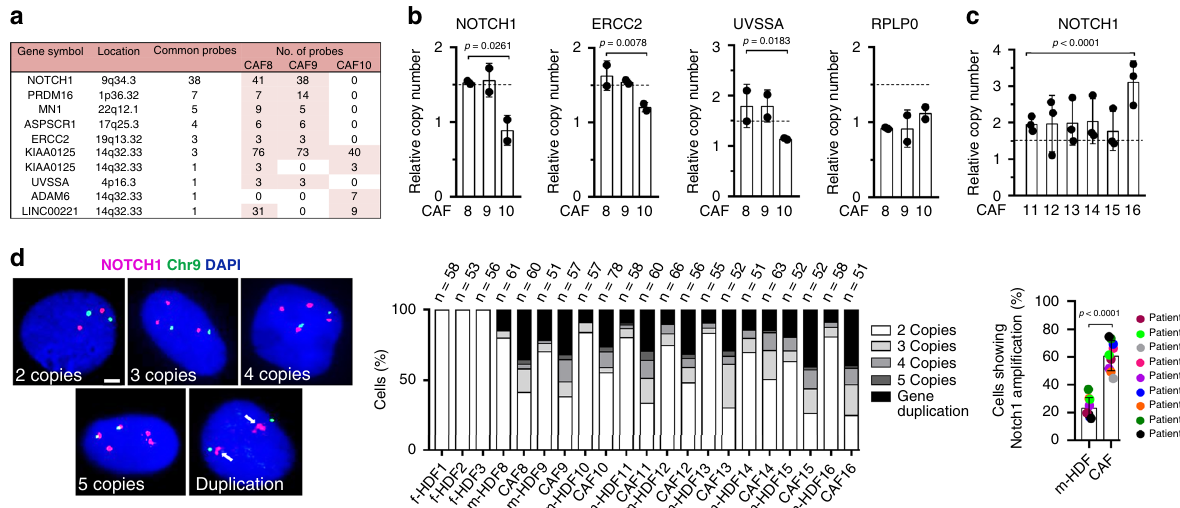
Fig. 1 NOTCH1 gene ampli fi cation in SCC-derived CAFs. a List of genes commonly ampli fi ed in at least 2 out of 3 CAF strains (CAF 8, 9, 10) as identi fi ed by Comparative Genomic Hybridization array (aCGH). For each gene, the chromosomal location, number of positive probes, and number of common probes are indicated. A complete list of copy number variations (CNVs) identi fi ed by aCGH of each CAF strain is provided in Supplementary Data 1. b Validation of NOTCH1 , ERCC2 , and UVSSA gene ampli fi cations in the same CAFs as in a , by qPCR analysis of two independent culture experiments (individual results indicated by dots) of the same strains. GAPDH was used for the internal normalization and RPLP0 was used as negative control. DNA copies were calculated relative to three foreskin-derived HDF strains (f-HDF) as outside reference following the same approach as in refs. 20,21 . Data are presented as mean ± s.d. One sample t -test, * p < 0.05, ** p < 0.01. n (CAF strain) = 3, n (f-HDF strain) = 3. c Quanti fi cation of NOTCH1 gene copy number in six additional CAF strains (CAFs 11-16) from three independent culture experiments of the same strains (individual results indicated by dots). DNA copies were calculated relative to three foreskin-derived HDF strains (f-HDF) strains as outside reference as in b . Data are presented as mean ± s.d. One sample t -test, **** p < 0.0001. n (CAF strain) = 6, n (f-HDF strain) = 3. d Representative images and quanti fi cation of percentage of cells with NOTCH1 gene copy number variations in 9 CAF strains as in b and c , their respective m-HDFs and three unmatched f-HDFs from healthy donors as assessed by FISH with a NOTCH1 -speci fi c probe (magenta) in parallel with a probe for chr9 q21.3 localization (green). Gene duplications are de fi ned as multiple proximal NOTCH1 positive dots per chromosome. The number of analyzed nuclei (n) obtained from two independent experiments are shown on top of the corresponding bar. Overall quanti fi cation and statistical signi fi cance of percentage of cells with NOTCH1 ampli fi cations in CAFs versus m-HDFs. Scale bar, 50 μ m. Values for each strain are indicated as dots with mean ± s.d. Two-tailed paired t -test between m-HDF and CAF, **** p < 0.0001. n (CAF strains) = 9, n (m-HDF strains) = 9, n (f-HDF strains) =